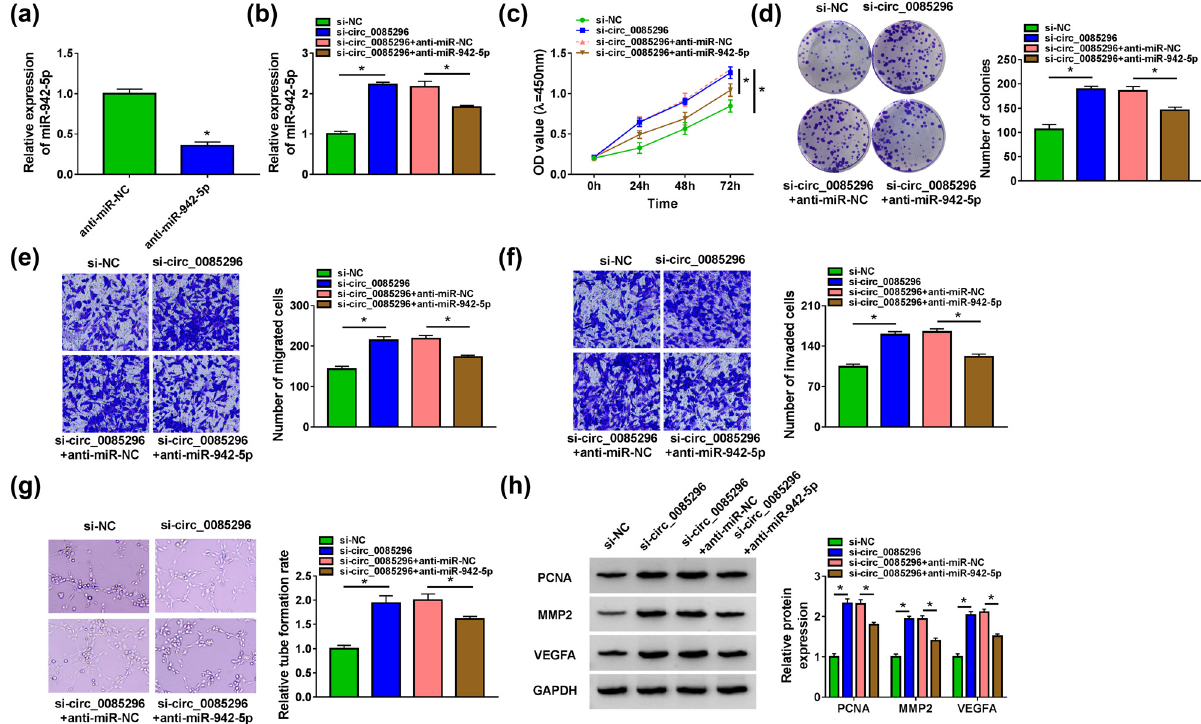
Figure 4: E ff ects of si - circ_0085296 and anti - miR - 942 - 5p on the biological functions of HTR8/SVneo cells. ( a ) The miR - 942 - 5p expression was detected by qRT - PCR to assess the transfection e ffi ciency of anti - miR - 942 - 5p. ( b – h ) HTR - 8/SVneo cells were transfected with si - NC, si - circ_0085296, si - circ_0085296 + anti - miR - NC, or si - circ_0085296 + anti - miR - 942 - 5p. ( b ) The expression of miR - 942 - 5p was measured by qRT - PCR. Cell proliferation, migration, invasion, and angiogenesis were determined by CCK8 assay ( c ) , colony formation assay ( d ) , Transwell assay ( e and f ) , and tube formation assay ( g ) , respectively. ( h ) WB analysis was performed to examine the protein levels of PCNA, MMP2, and VEGFA. * P < 0.05.